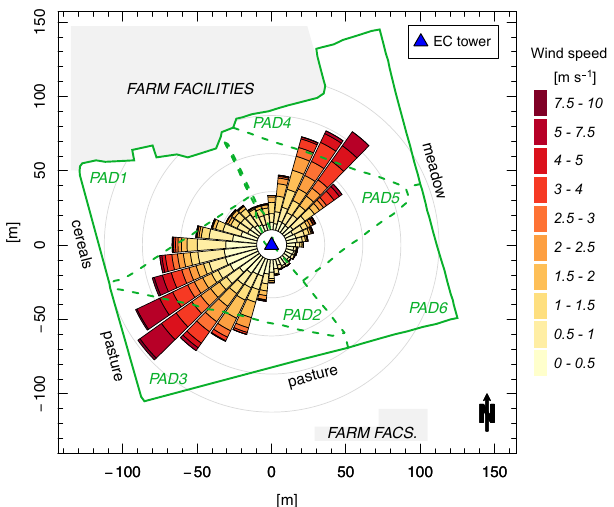
Figure 1. Plan of the measurement site with the pasture (solid green line) and its division into six paddocks, PAD1 to PAD6 (dashed green lines), used for rotational grazing. Around the EC tower in the center, the wind direction distribution for the year 2013 is in- dicated with a resolution of 10 ◦ . The gray circles indicate sector contributions of 2, 4, 6, and 8% (from inside outwards). Each sec- tor is divided into color shades indicating the occurrence of wind speed classes (see